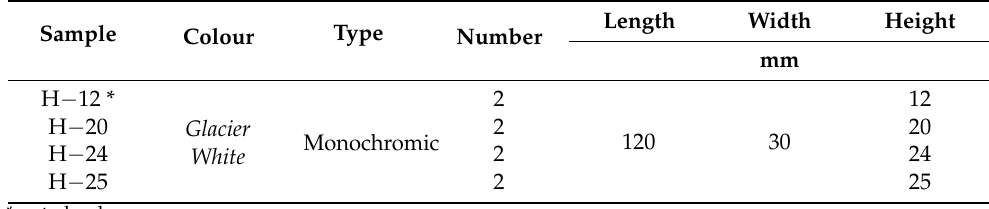
Table 3. Characteristics of glued artificial stone.